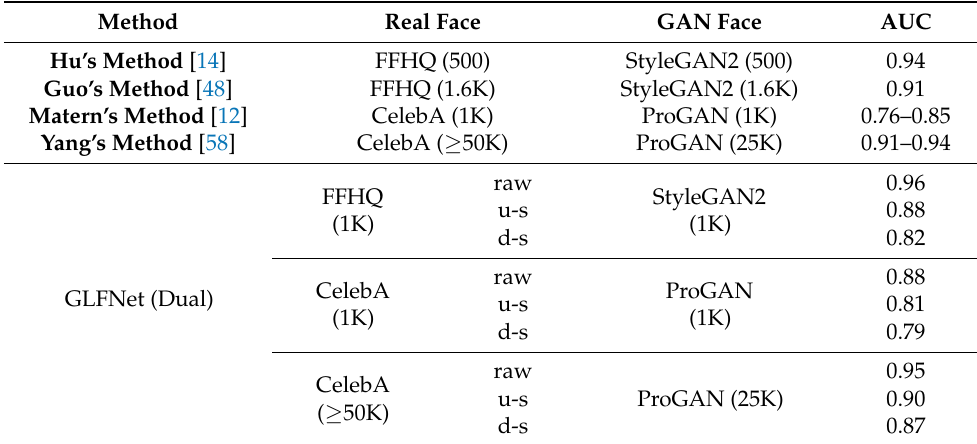
Table 7. Comparison of classification AUC (%) with state-of-the-art